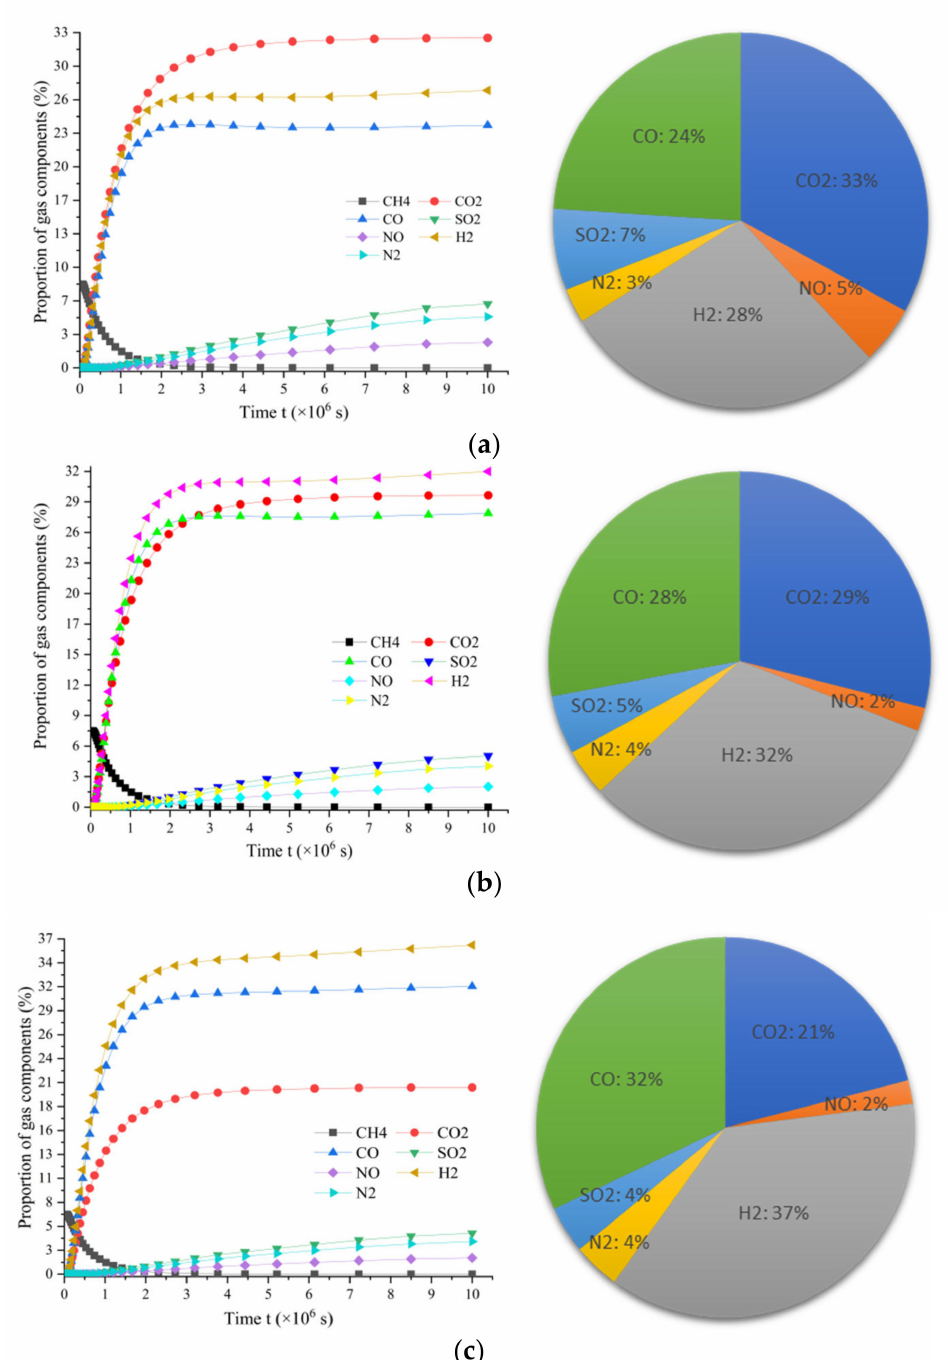
Figure 10. Proportions of gas components with different water-oxygen ratios. ( a ) Gasifier water-to- oxygen ratio 1:2; ( b ) gasifier water-to-oxygen ratio 1:1; ( c ) gasifier water-to-oxygen ratio